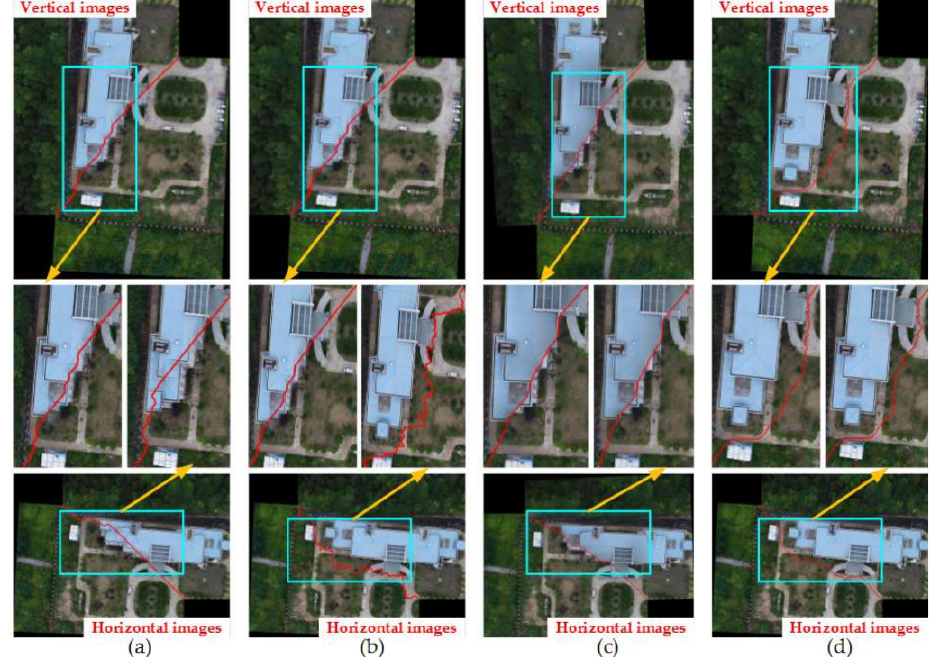
Figure 14. The seam-lines of four search methods for Figure 7c: ( a ) Dulapquet3-DP; ( b ) Dulapquet4-DP; ( c ) OpenCV-DP; ( d )